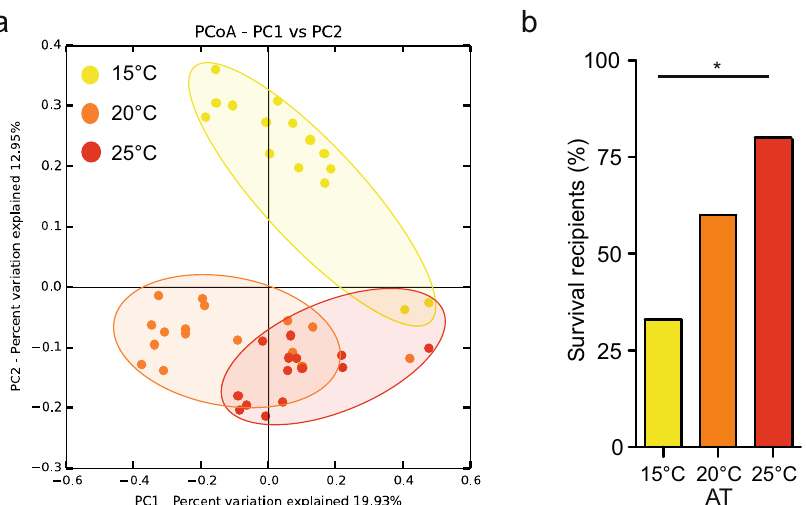
Fig. 5 Transplantation of acclimated microbiota confers thermal resistance. a PCoA (based on the binary-Pearson metric, sampling depth = 3600) illustrating similarity of recipient bacterial communities based on AT of donor microbiota. b Heat stress (40 °C, 6 h) survival of recipient polyps. Statistical analyses were performed by pairwise Fisher ’ s exact test ( n = 15, * p = 0.025). Box plots are presenting center line, median; box limits, upper and lower quartiles; whiskers, 1.5x interquartile range.